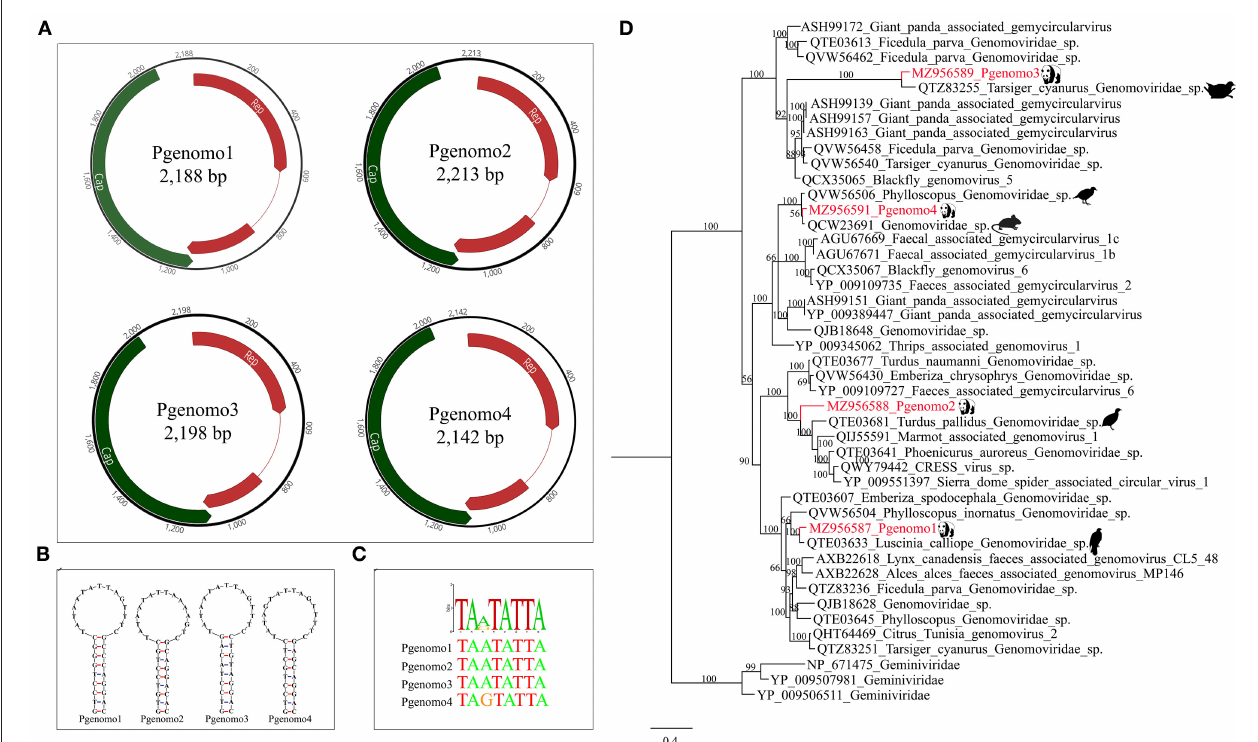
FIGURE 3 | Phylogenetic analysis and genomic organization of the family Genomoviridae in the giant pandas. (A) Genomic organization of four sequences related to family Genomoviridae . (B) The stem-loop structures of the four genomes identified in giant pandas. (C) The non-amer in the stem-loop structure of the four genomes identified in giant pandas. (D) Phylogenies of viruses belonging to family Genomoviridae identified in giant pandas. Bayesian inference tree based on amino acid sequences of Rep of viruses belonging to family Genomoviridae identified here. Within trees, the viruses found in this study are marked with red line. Each scale bar indicates 0.4 amino acid substitutions per